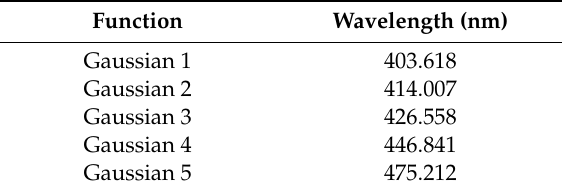
Table 2. Common template wavelengths.